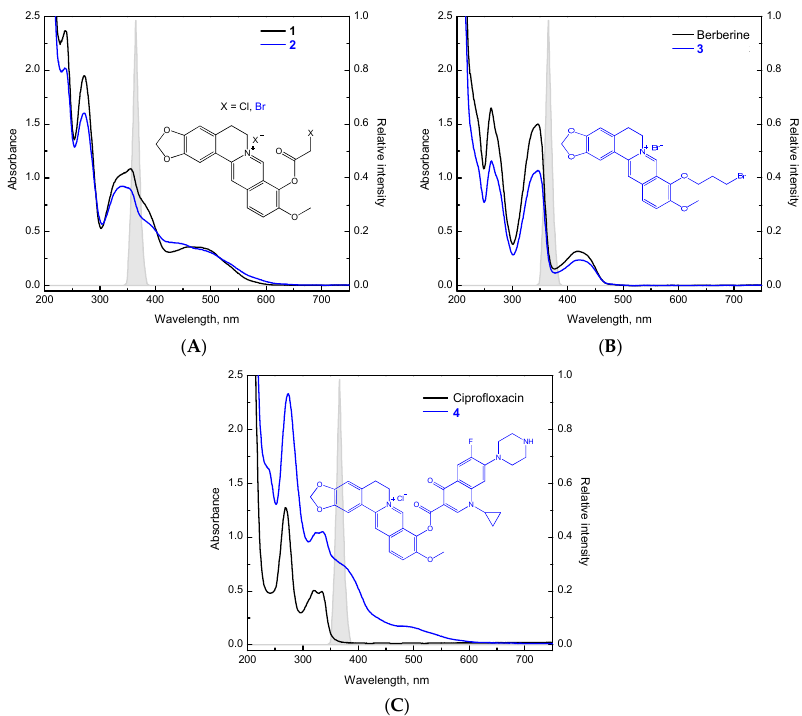
Figure 2. Electronic absorption spectra of ( A ) berberine derivatives 1 and 2 , ( B ) berberine and berberine derivative 3 , ( C ) ciprofloxacin and berberine derivative 4 , all in the mixed solvent DMSO / water (1:100, v : v ; concentration 0.07 mM). Each graph contains the relative spectral distribution of the UVA LED source ( λ max = 365 nm) applied in the EPR spin trapping experiments.